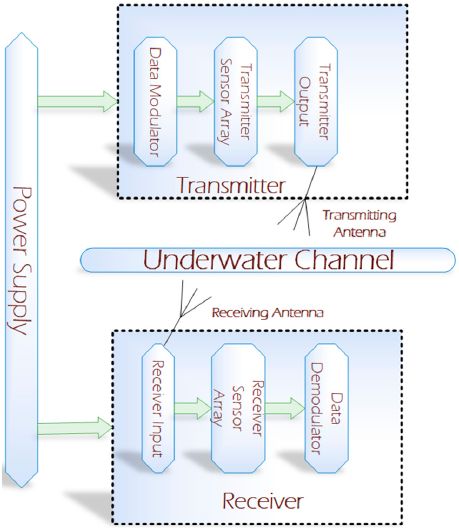
Figure 4. Block diagram of underwater electromagnetic communication.